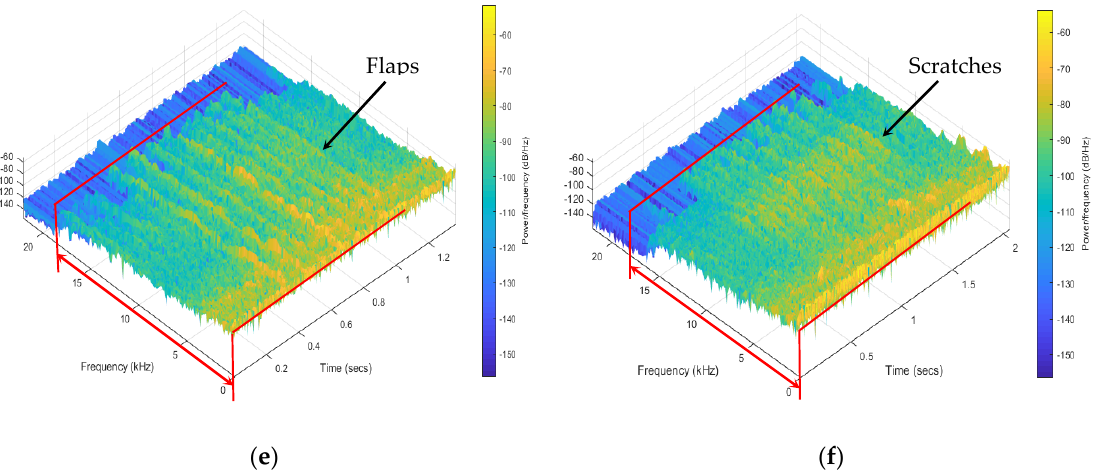
Figure 2. Example signals of bird vocalization ( a ), fan ( b ), feed system ( c ), heater ( d ), wing flapping ( e ) and dustbathing ( f ) in frequency domain.